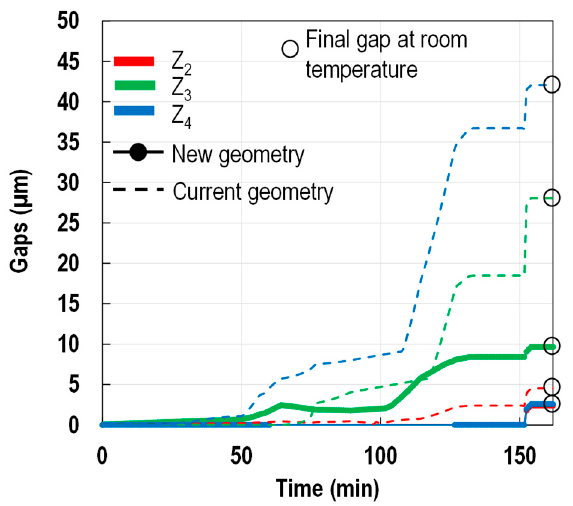
Figure 16. Influence of the additional material on final gap after annealing (Figure 1c) along the electrode’s axis.